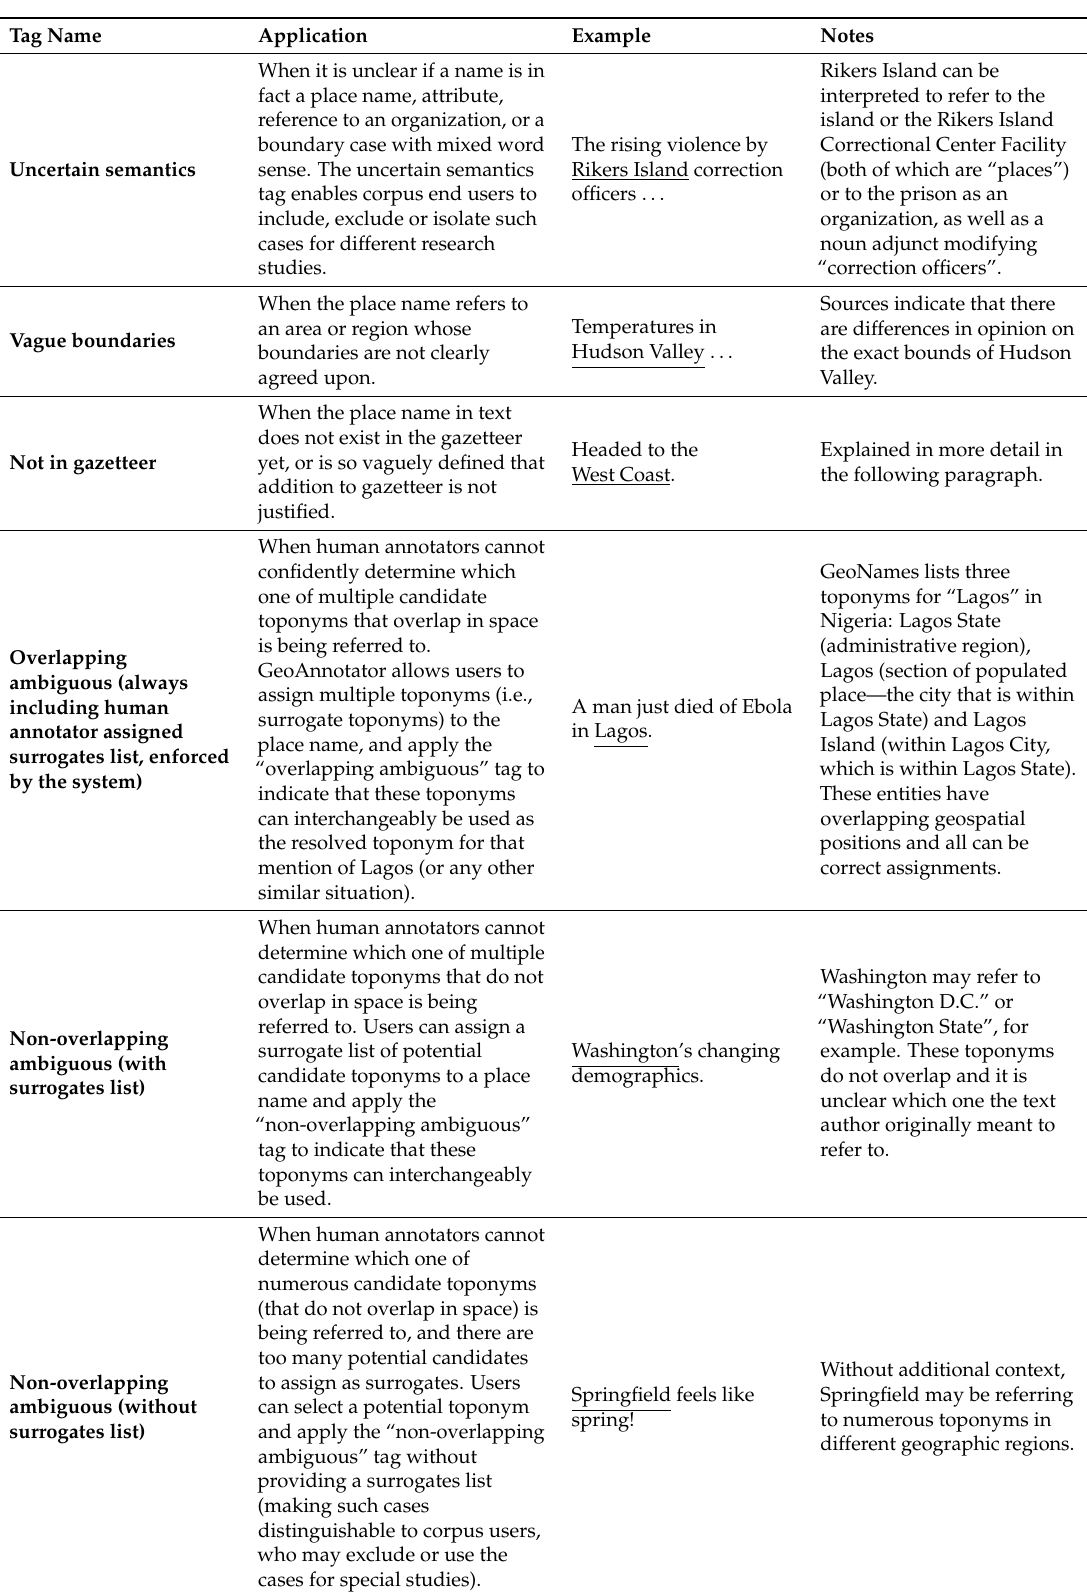
Table 1. Special tags in GeoAnnotator to demarcate special cases of toponyms. For each special case, an example is provided with the place name